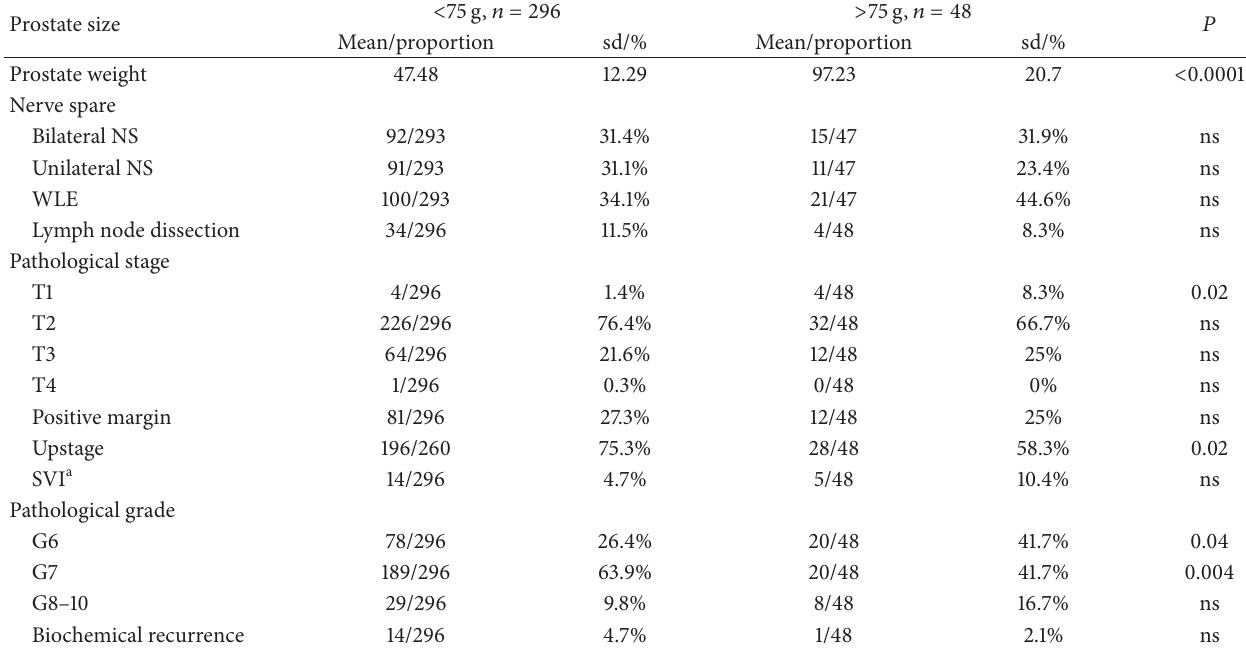
Table 2: Pathology and oncological outcomes of RALP.